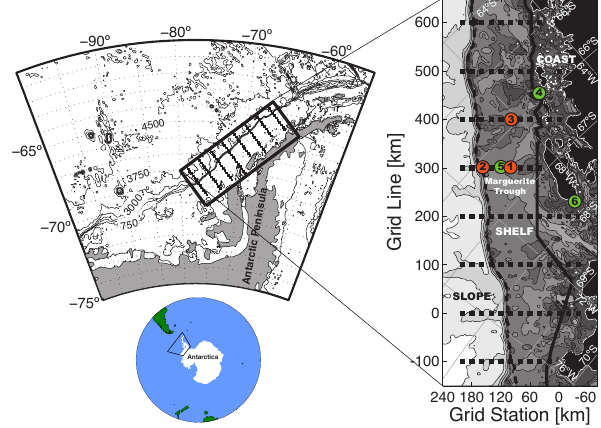
Fig. 1. Location of LTER marine sampling grid from which data for this study have been acquired. Shipboard (CTD) sampling loca- tions shown as solid squares. Numbered circles in sample grid (right panel) show the various mooring locations during the years of data included in this study (2007–2010); Table 1 lists the specific moor- ing locations for each year. Mooring #1 was deployed in 2007 as part of the LTER project. All others in 2008 and beyond as part of the IPY SASSI project (never more than five moorings deployed in any one year). Gold colored mooring sites are the most consistently occupied and the primary focus of this study, green ones less so. Marguerite Trough (labeled) cuts across the center of the shelf into Marguerite Bay. Grid bathymetry shaded between contours every 150m from 200m until 750, and then at 750m intervals until